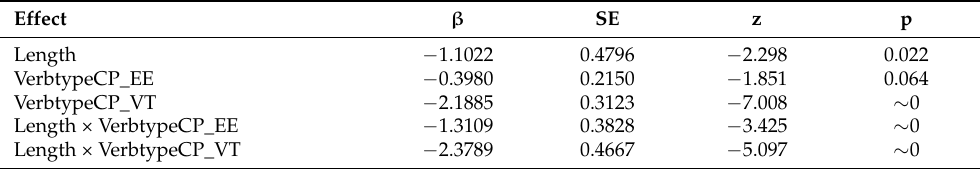
Table A19. Coefficient estimates for Experiment 2 mixed-effects model.